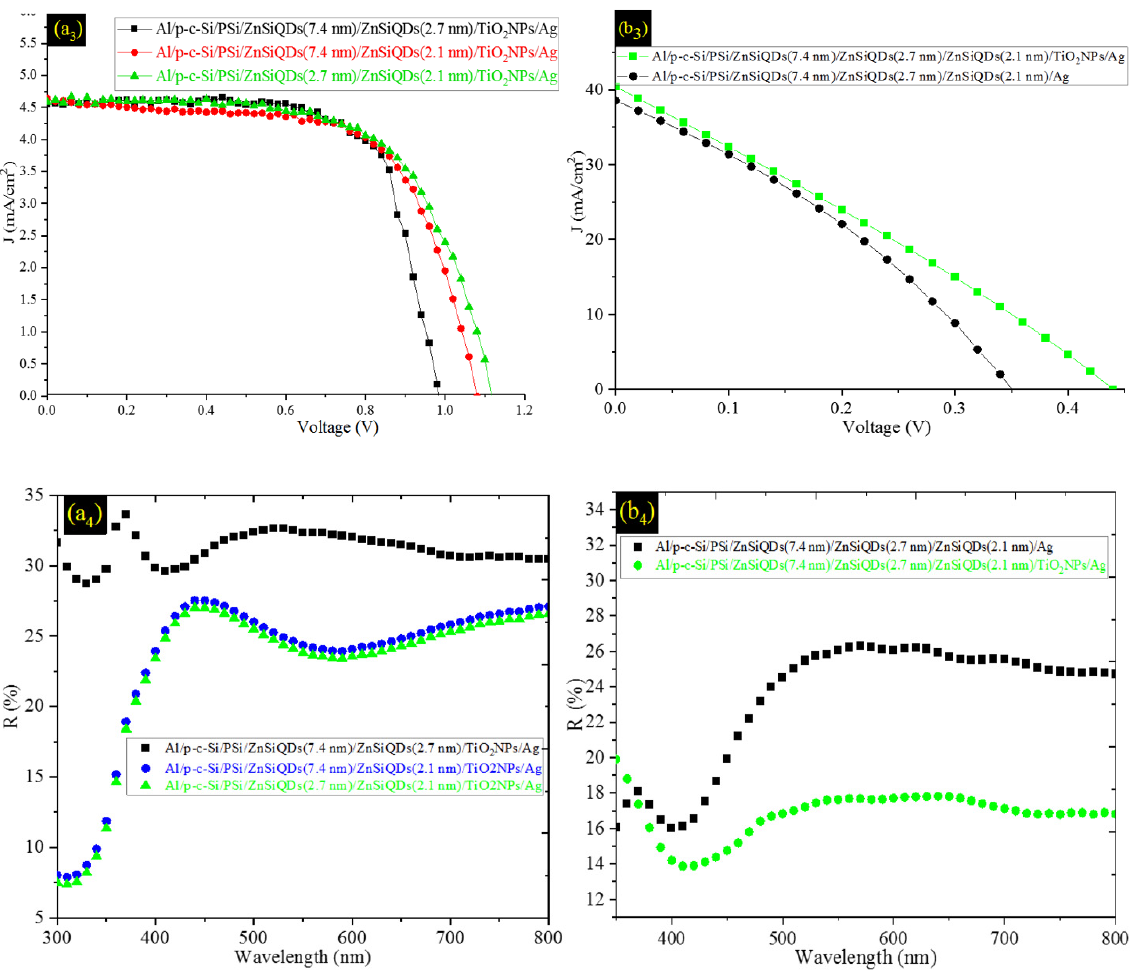
Figure 8. Architectures of the solar cells obtained with PSi, TiO 2 NPs ( a 1 , b 1 , c 1 ) DL-ZnSiQDs; ( d 1 , e 1 ) TL-ZnSiQDs. FESEM image ( a 2 ) cross-section view of the p-c-Si/ PSi/TL-ZnSiQDs/TiO 2 NPs cell with various dimensions (yellow) and ( b 2 ) top view of PSi and pores size distribution (histogram) with Gaussian fit (blue curve). Photovoltaic performance of the proposed solar cell fabricated with ( a 3 ) DL-ZnSiQDs and ( b 3 ) TL-ZnSiQDs. Reflection spectra of the solar cell made with ( a 4 ) DL-ZnSiQDs and ( b 4 ) TL-ZnSiQDs.